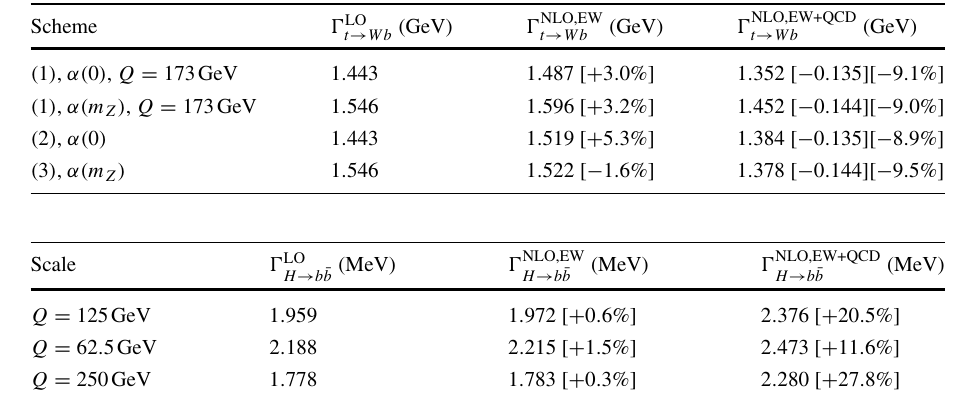
Table 1 Partial decay width t → Wb in different schemes, see text for details